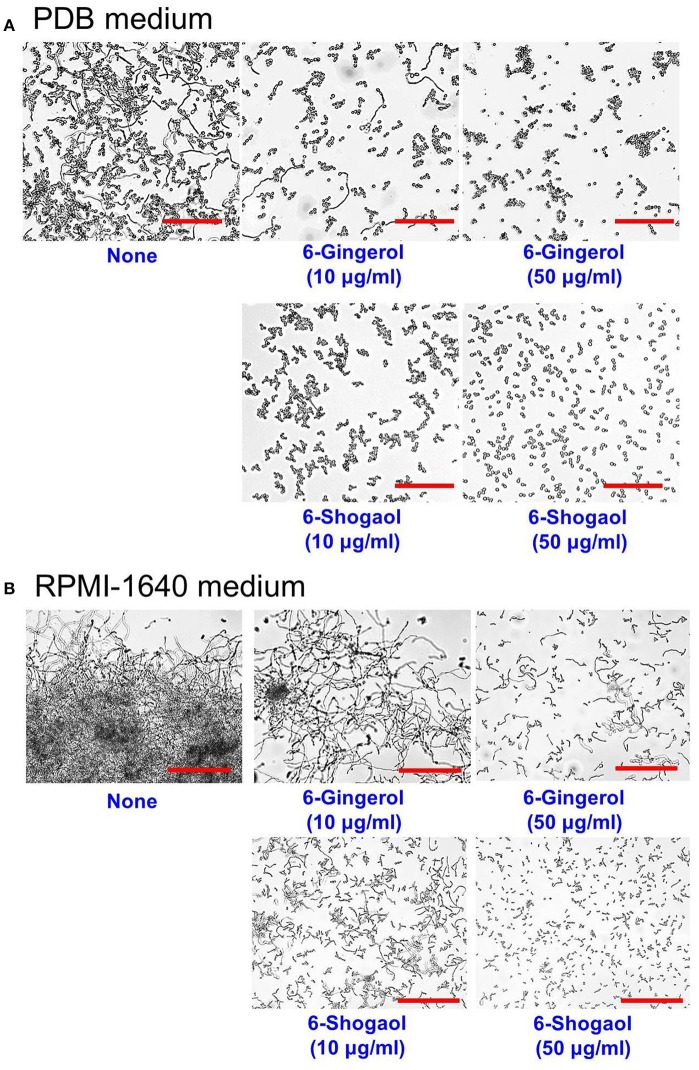
Inhibitions of hyphal filamentation and aggregation by 6-gingerol and 6-shogaol in liquid medium. Inhibitions of hyphal filamentation in PDB medium (A) and in RPMI medium (B). C. albicans cells were grown for 24 h in PDB medium or RPMI-1640 medium in the absence or presence of 6-gingerol or 6-shogaol. Hyphae were visualized after incubation for 24 h. The scale bar represents 200 μm. None; non-treated control.